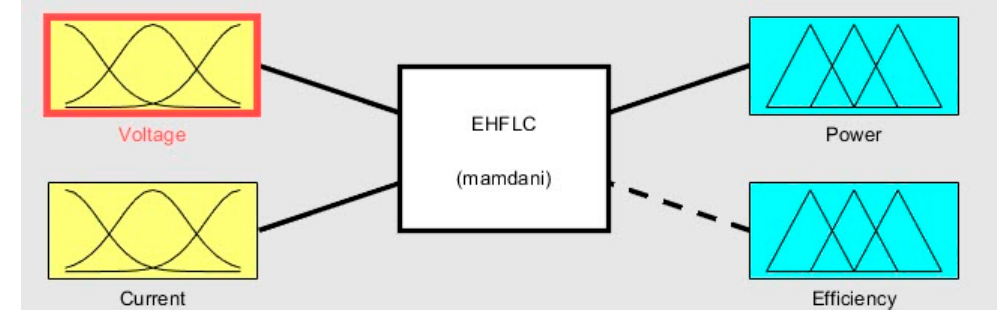
Figure 6. The energy harvester fuzzy logic controller (EHFLC).